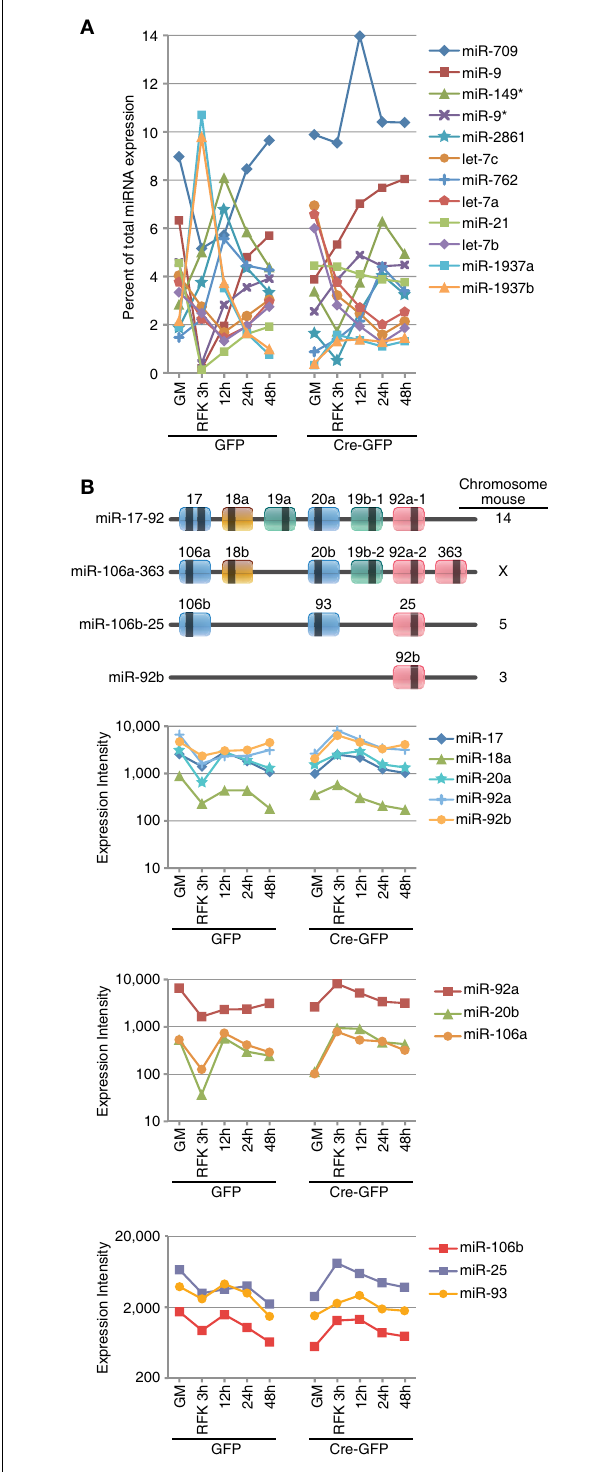
FIGURE 2 | REST ablation modulates the expression of numerous miRNAs during differentiation. (A) The top expressed miRNAs included the let-7 family, miR-709, -9, -21, and -1937a/b. Most of the top expressed miRNAs are either ubiquitously expressed or neural